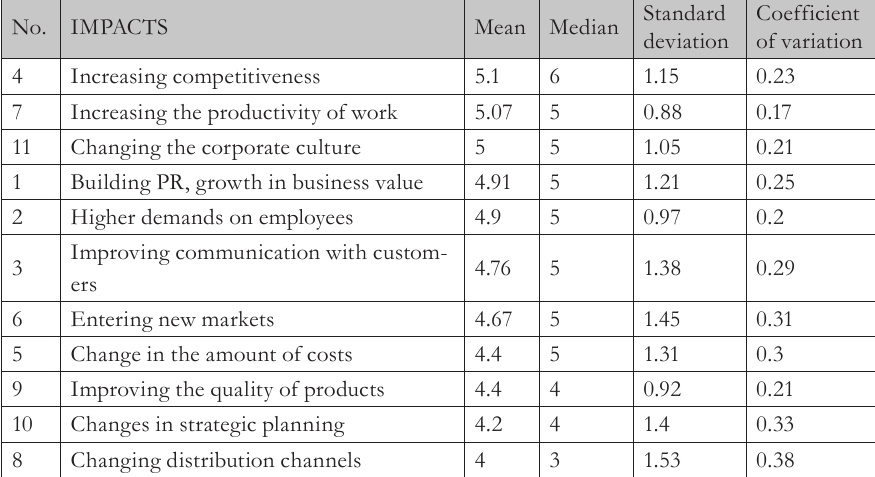
Tab. 3 - Evaluating the impact of implementing marketing innovation. Source: